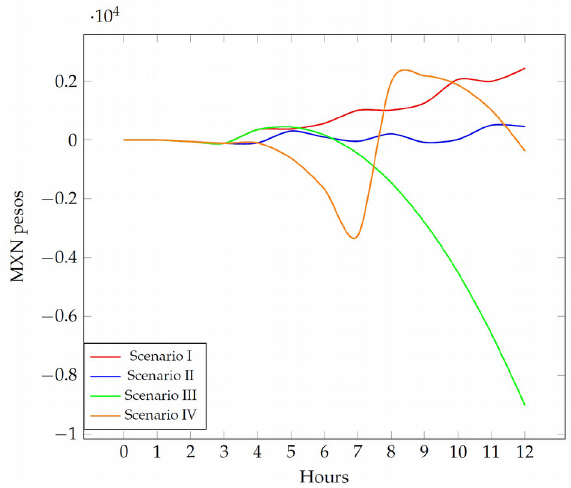
Figure 7. Profit performance from the